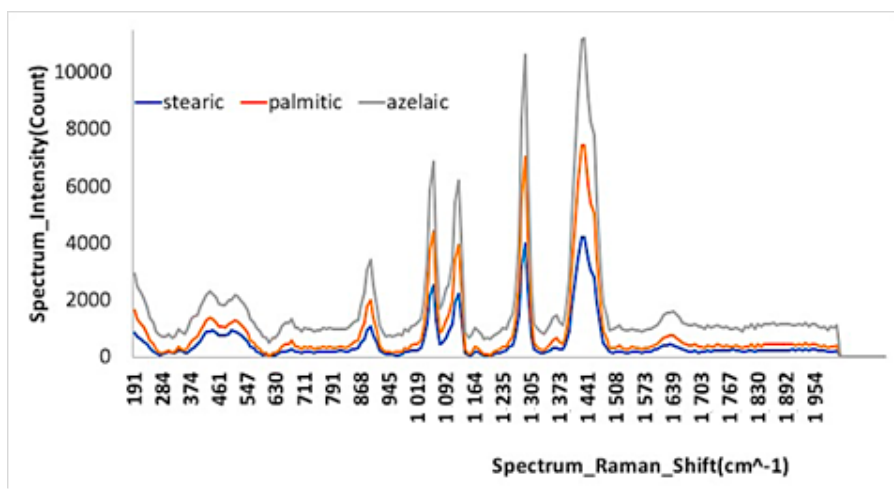
Figure 12. The Raman spectrum of fatty acids .